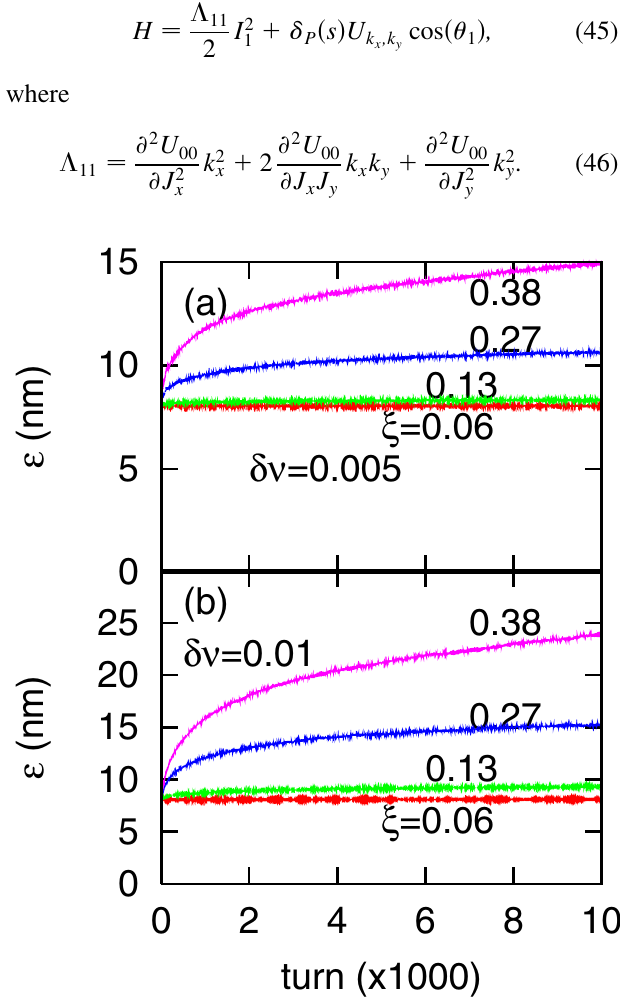
FIG. 16. (Color) Emittance growth for the system with 3 degrees (cid:4) (cid:5) (cid:3) 0 : 2876 ; 0 : 2926 (cid:4) and (b) (cid:3) 0 : 2851 ; ; (cid:8) of freedom; (a) (cid:3) (cid:8) x y 0 : 2951 (cid:4) . Particles do not experience synchrotron motion.